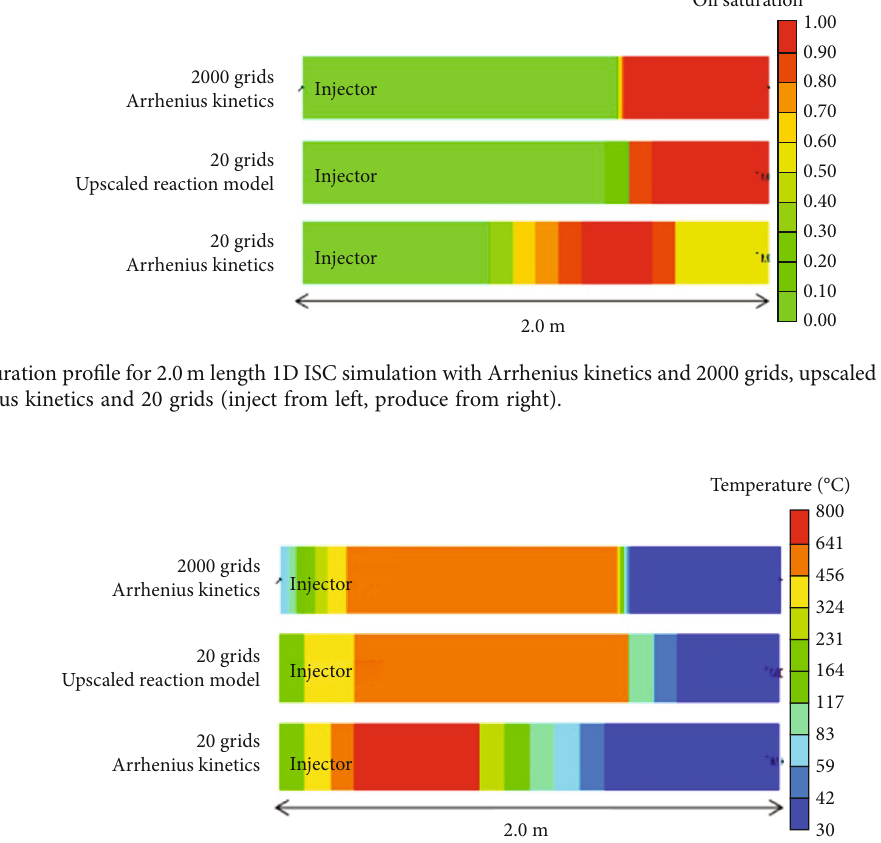
Figure 17: Temperature pro fi le for 2.0m length 1D ISC simulation with Arrhenius kinetics and 2000 grids, upscaled reaction model and 20 grids, and Arrhenius kinetics and 20 grids (inject from left, produce from